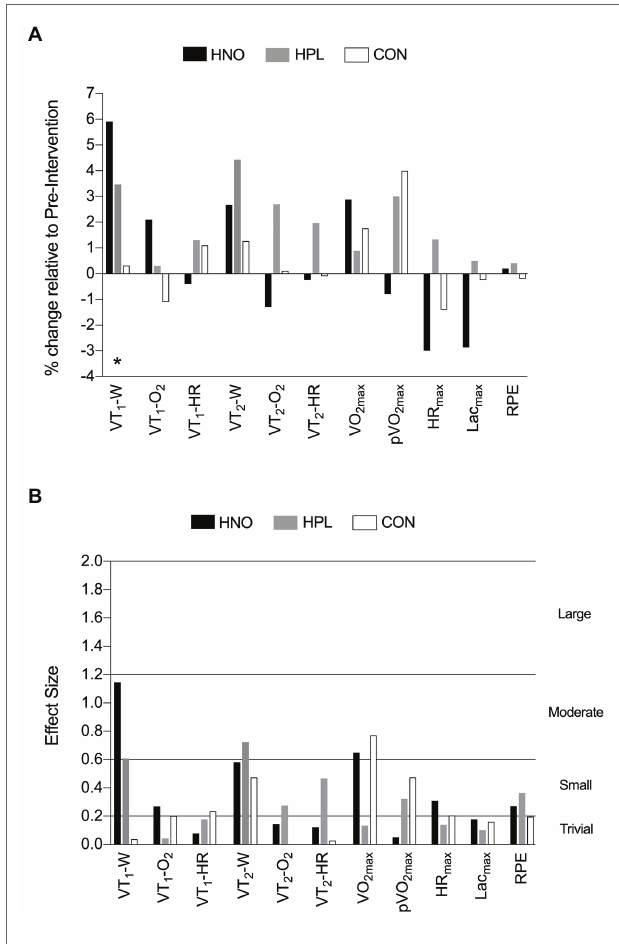
FIGURE 1 | The effects of 4-weeks training in the INC test-related parameters presented as mean percentage of change relative to pre- intervention period (post-intervention mean—pre-intervention mean/pre- intervention mean*100): (A) and the corresponding mean effect size (post- intervention mean—pre-intervention mean/square root of the sum of the two standard deviations minus 2*correlation coefficient): (B) following high- intensity exercise training sessions performed in hypoxia with NO 3 − (HNO: black), in hypoxia with placebo (HPL: gray), and in normoxia with placebo (CON: white). Threshold values considered for effect size were “trivial” (<0.2), “small” (0.2–0.6), “moderate” (0.6–1.2), and “large” (1.2–2.0). *Differences between hypoxia (HNO + HPL) vs. normoxia (CON; p <